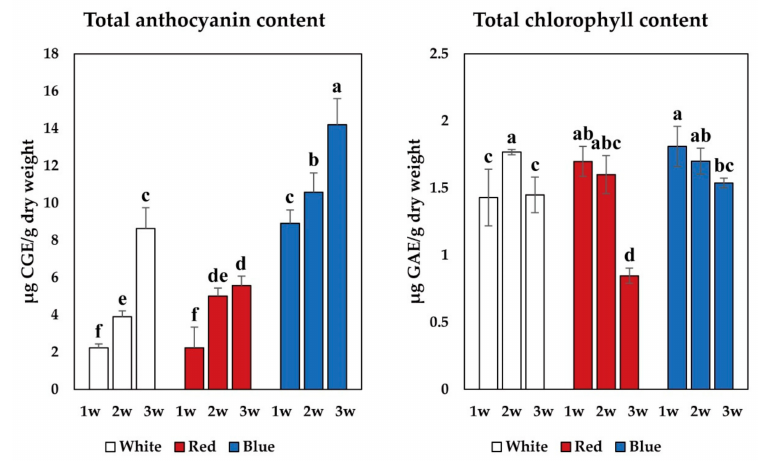
Figure 3. Total anthocyanin content and total chlorophyll content of B. juncea sprouts grown under LED illumination of varying duration. Di ff erent letters indicate a significant di ff erence among means, applying Duncan’s multiple range test ( p < 0.05), and bars represent standard deviation of the mean.